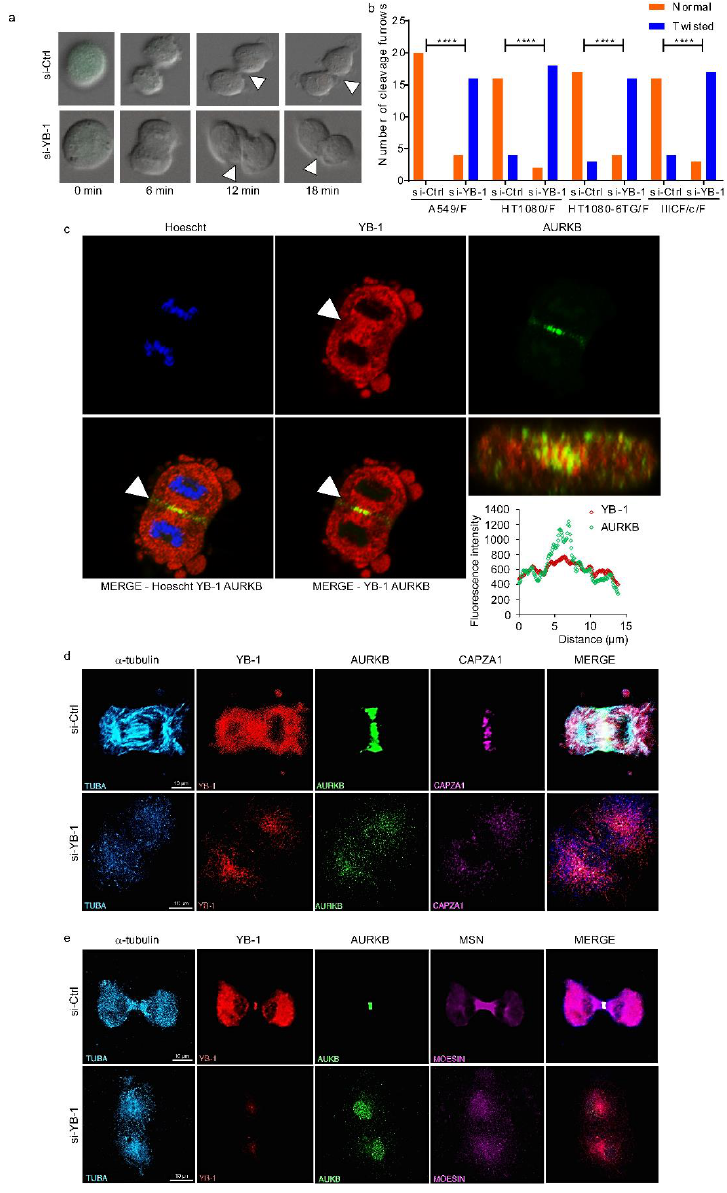
Figure 2. YB-1 depletion results in failure of Chromosome Passenger Complex (CPC) recruitment to the cleavage furrow. ( a ) Examples from live cell imaging of an A549 / F cell treated with si-Ctrl and forming a stable cleavage furrow (left panel) or si-YB-1 and forming a twisted cleavage furrow (right panel). Images were acquired with a 20 × objective. ( b ) Quantitation of normal versus twisted cleavage furrows in A549 / F, HT1080 / F, 6TG / F and IIICF / c / F cells treated with either control siRNA (si-Ctrl) or targeting YB-1 (si-YB-1). Twenty cells were counted for each condition. Significance was determined using Chi-Square and Fisher’s Exact test. p < 0.05 was considered to be significant. **** p < 0.0001. ( c ) Enrichment of YB-1 at the cleavage furrow in A549 cells. ( d , e ) A549 cells were treated with either an si-Ctrl (top row) or an si-YB-1 (bottom row) and subsequently immunostained with antibodies against (from left to right) α -tubulin (cyan), YB-1 (red), AURKB (green), CAPZA1 or MSN (magenta) together with a merged image of all four. ( d ) Accumulation of CAPZA1 to the cleavage furrow and ( e ) accumulation of MSN to the cleavage furrow. ( c – e ) Images were acquired using a 60x oil-immersion